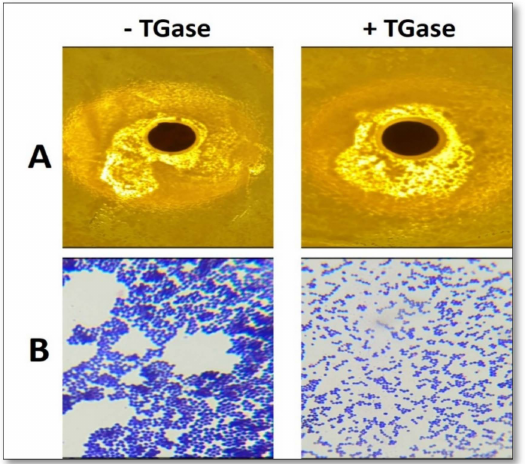
Figure 7. SEM analysis (10,000 × magnification) of the surfaces ( A ) and cross-sections ( B ) of Nigella sativa defatted seed cake ( Ns DSC)-derived films obtained in the absence ( A ) and presence ( B ) of transglutaminase (TGase)